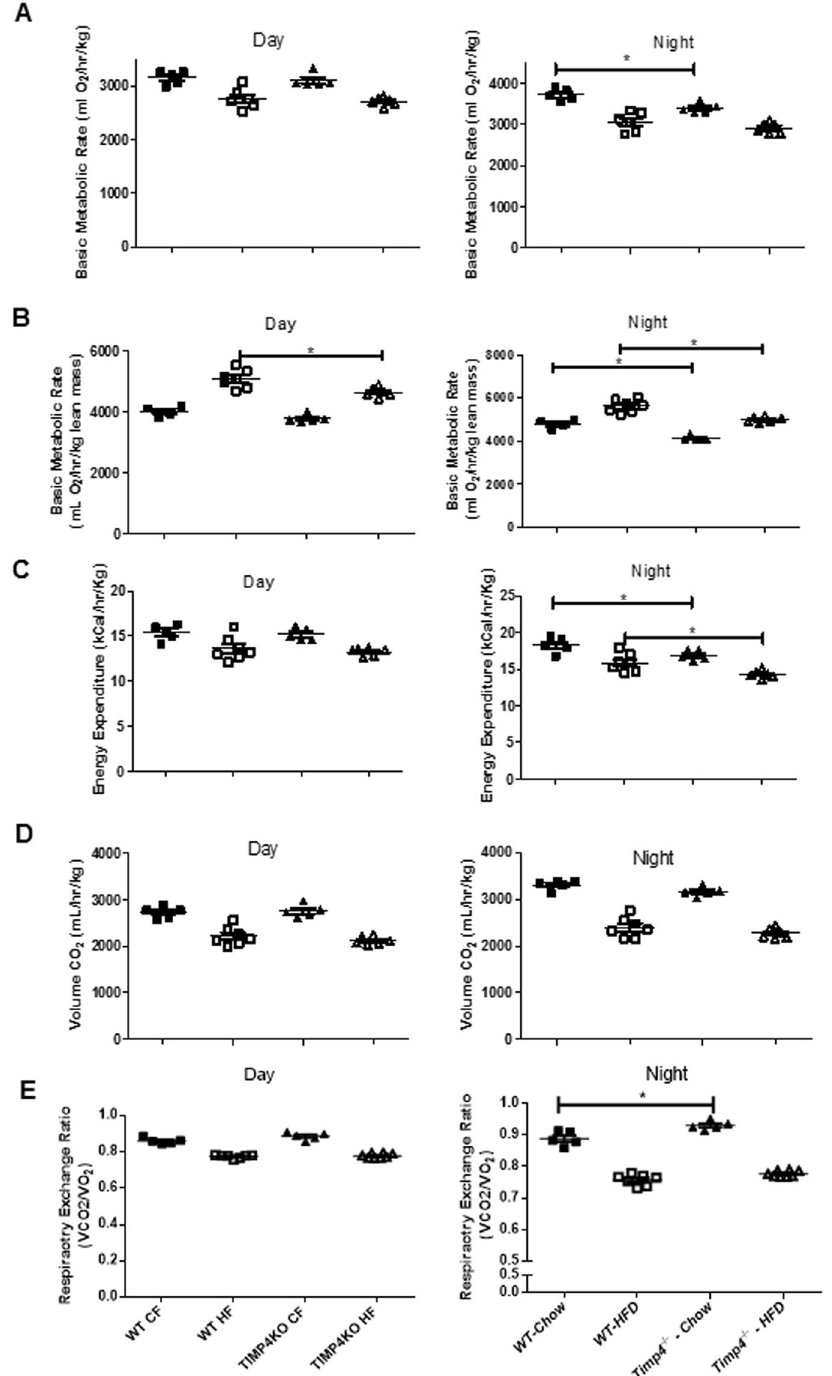
Figure 7. Reduced basic metabolic rate, energy expenditure and increased respiratory exchange ratio in Timp4 − / − mice. Basic metabolic rate corrected for body weight (BMR)( A ), basic metabolic rate corrected for lean mass ( B ), energy expenditure ( C ), volume of released CO 2 ( D ), and respiratory exchange ratio (RER) ( E ) during day (i) and nigh time (ii) in chow- or HFD-fed WT and Timp4 − / − mice. Significance between the chow-fed and HFD-fed groups within the genotypes are not shown in the figure. Averaged data are presented as mean ± S.E.M and analyzed by ANOVA. * indicates significance (p <